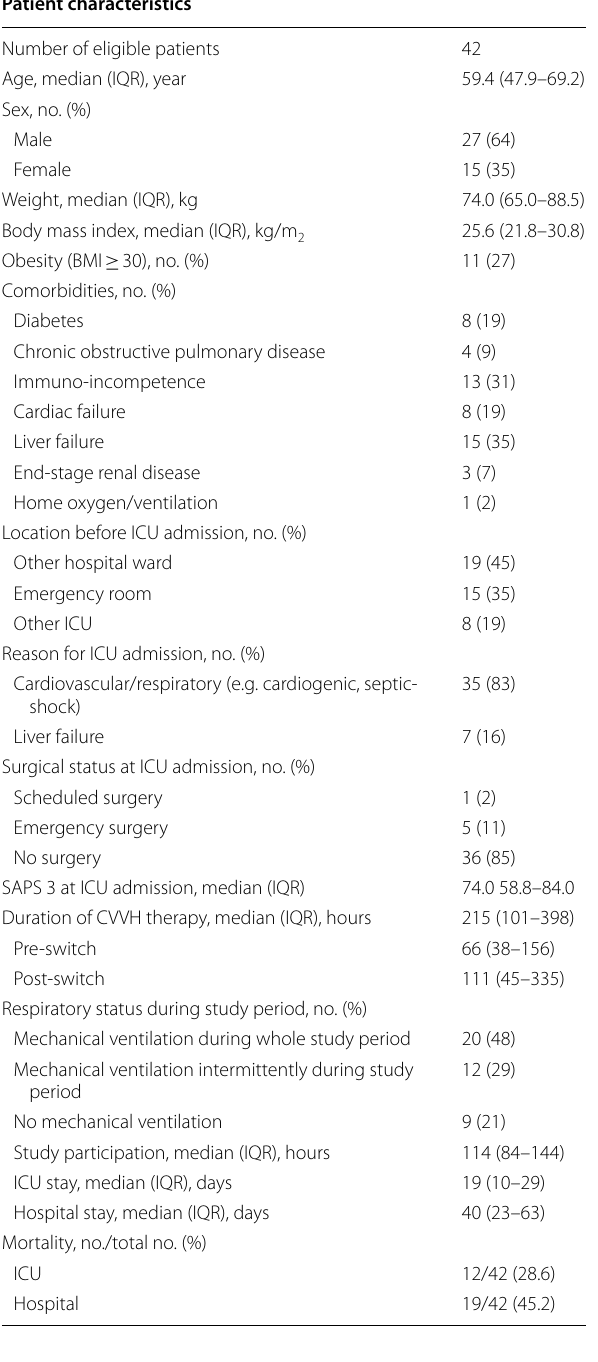
Table 2 Baseline characteristics of included patients Patient